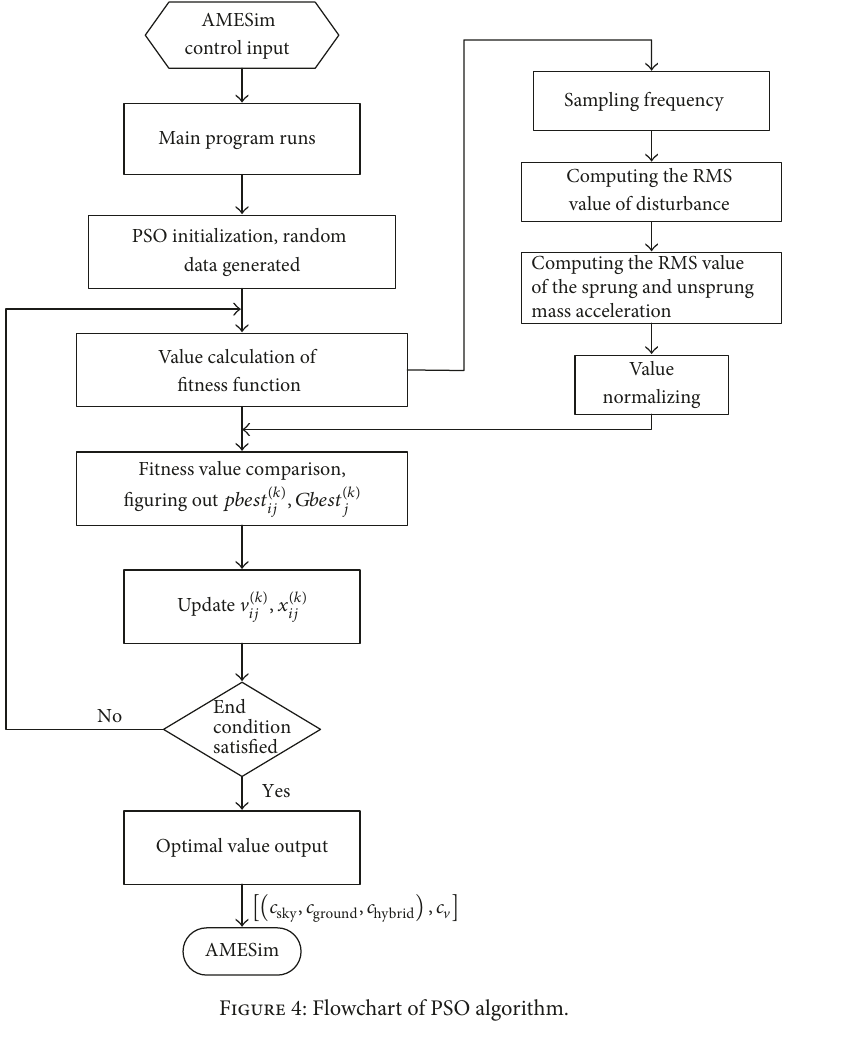
Figure 4: Flowchart of PSO